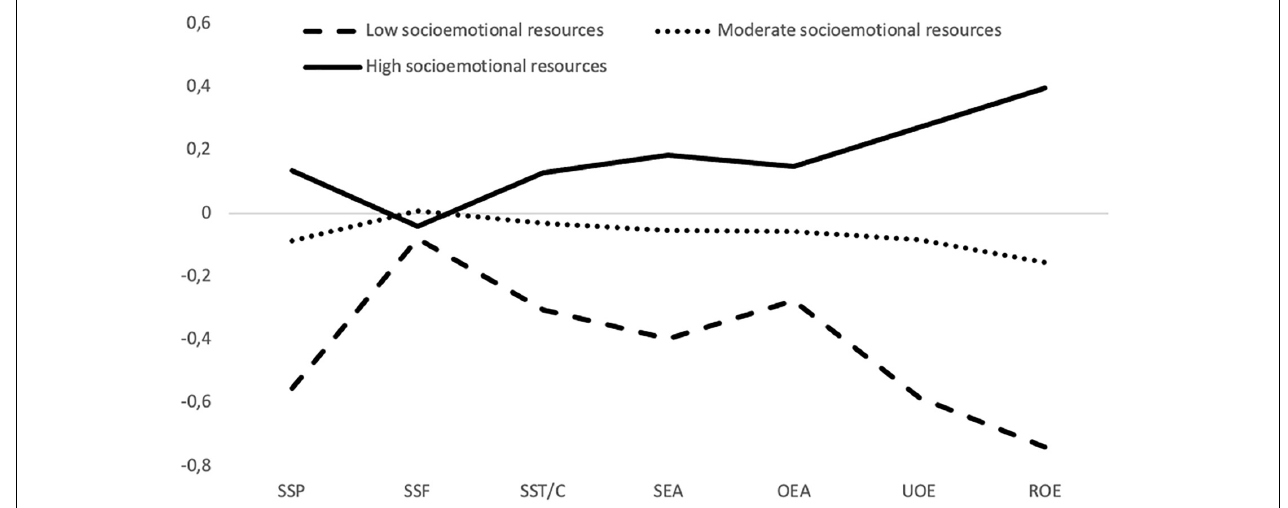
FIGURE 1 | Latent profiles of adolescents. SSP, social support from parents; SSF, social support from friends; SST/C, social support from teachers/counselors; SEA, self-emotional appraisal; OEA, others’ emotional appraisal; UOE, use of emotion; ROE, regulation of